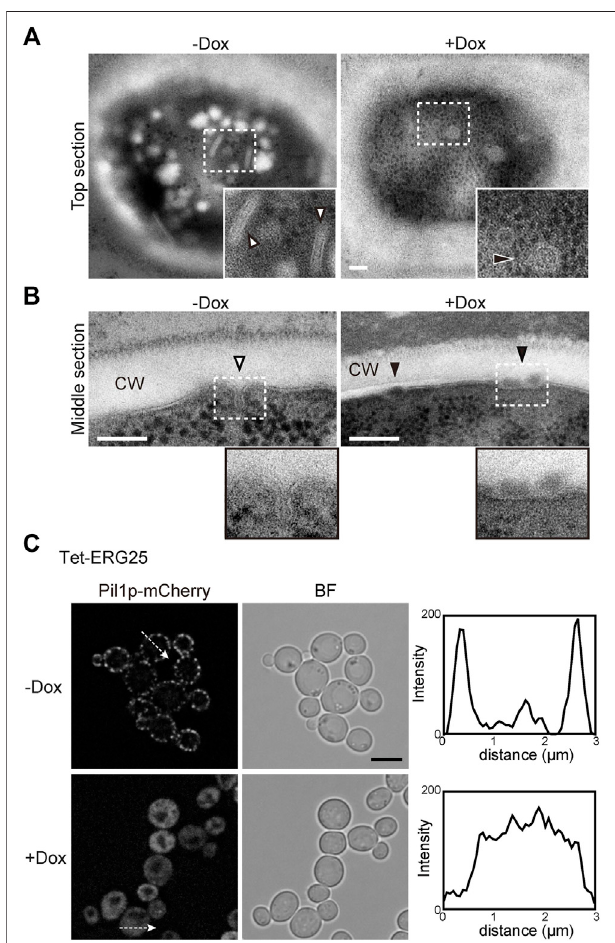
FIGURE 6 | ERG25 knockdown has effect on the structure of MCC/ eisosomes. (A) Observation of furrow-like invaginations in Tet-ERG25 cells using transmission electron microscopy (TEM). Cells were incubated at 37 ° C in minimal medium containing 10% (v/v) bovine serum with or without Dox for 17 h, and then fi xed. Ultrathin sections (70-nm thicknesses) of the cell surface were observed. The furrow-like invaginations in Dox-untreated cells areindicatedbywhitearrowheads,andabnormalinvaginationsinDox-treated cells are indicated by black arrowheads. The dashed lines surround areas shown at higher magni fi cations in the lower right. Scale bars represent 100 nm. CW; cell wall. (B) TEM images of the cells sectioned through the middle of the cells. (C) Effect of ERG25 knockdown on the localization of Pil1p-mCherry. Tet-ERG25 cells expressing Pil1p-mCherry (Tet- ERG25_Aus1G/Pil1R) were grown to exponential phase at 37 ° C in minimal medium containing bovine serum and further incubated for 17 h in the absence or presence of Dox. Intensity pro fi ling of Pil1p-mCherry was carried out along the dashed arrows. Scale bar represents 5 µm.